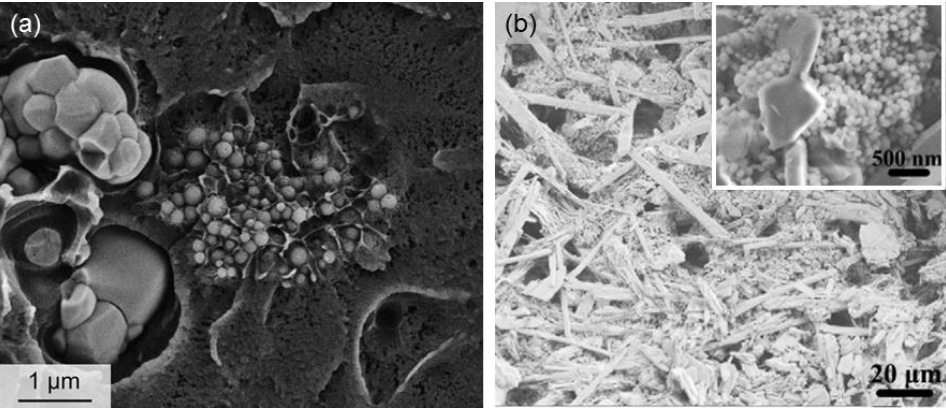
Figure 5. SEM micrographs of mesoporous silica nano-spheres incorporated in bone cements with a matrix of ( a ) poly(methyl methacrylate) (image adapted from Slane et al. [67] © Elsevier) or ( b ) calcium sulfate needles (image adapted from Li et al. [68] © Elsevier).